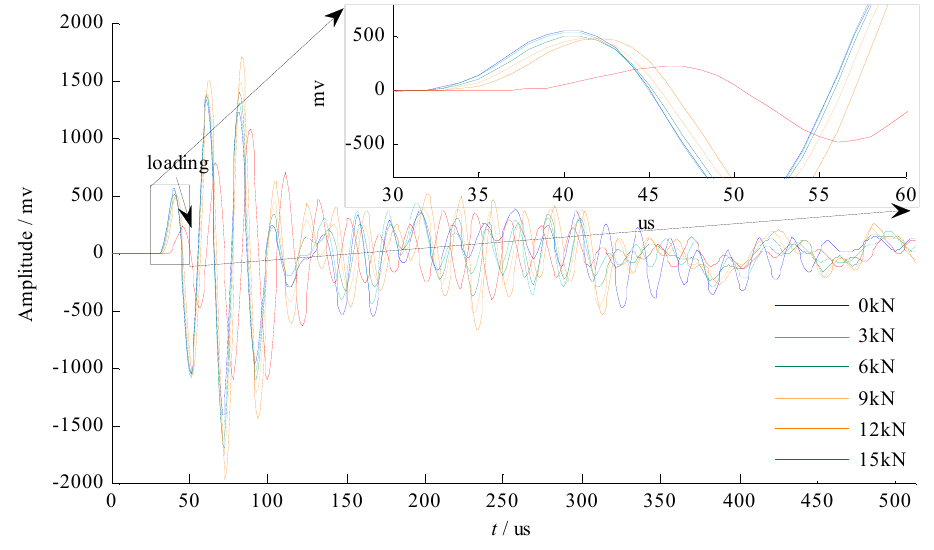
Figure 5. Transmission waveform during the destruction.